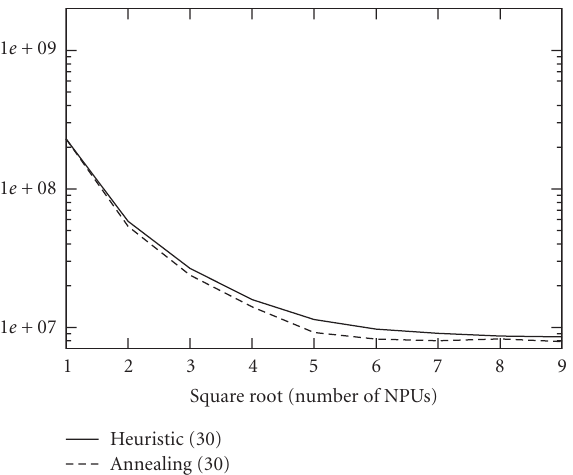
Figure 14: Objective function values for a fixed task count (30) and di ff erent array sizes.